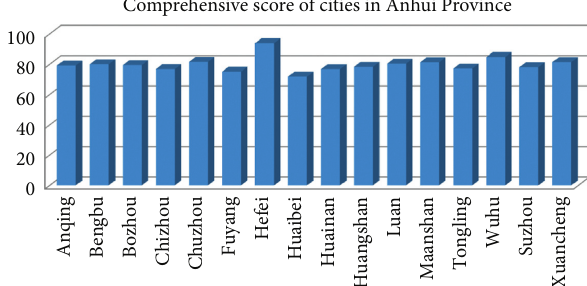
Figure 1: Comprehensive score of cities in Anhui Province.